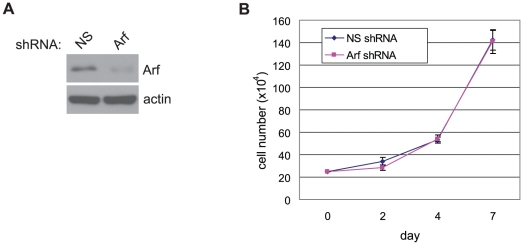
Knockdown of Arf does not affect growth of SV-40 Tag oncogene expressing β-tumor cells.Tumor cells were stably transduced with a non-silencing (NS) or Arf silencing shRNA. (A) Knockdown of Arf protein expression by the Arf targeting shRNA. β-actin protein levels indicated as a control for protein load. (B) Effect of Arf knockdown on tumor cell growth in vitro. Mean values +/−SEM from three independent experiments performed in triplicate are indicated.